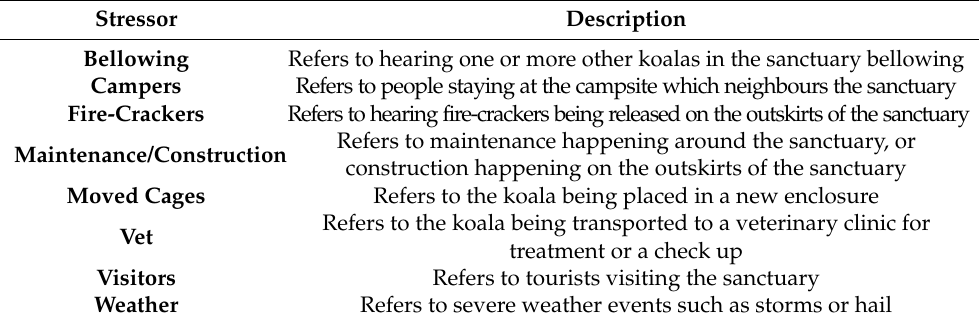
Table 1. Various stressors experienced by koalas within clinical